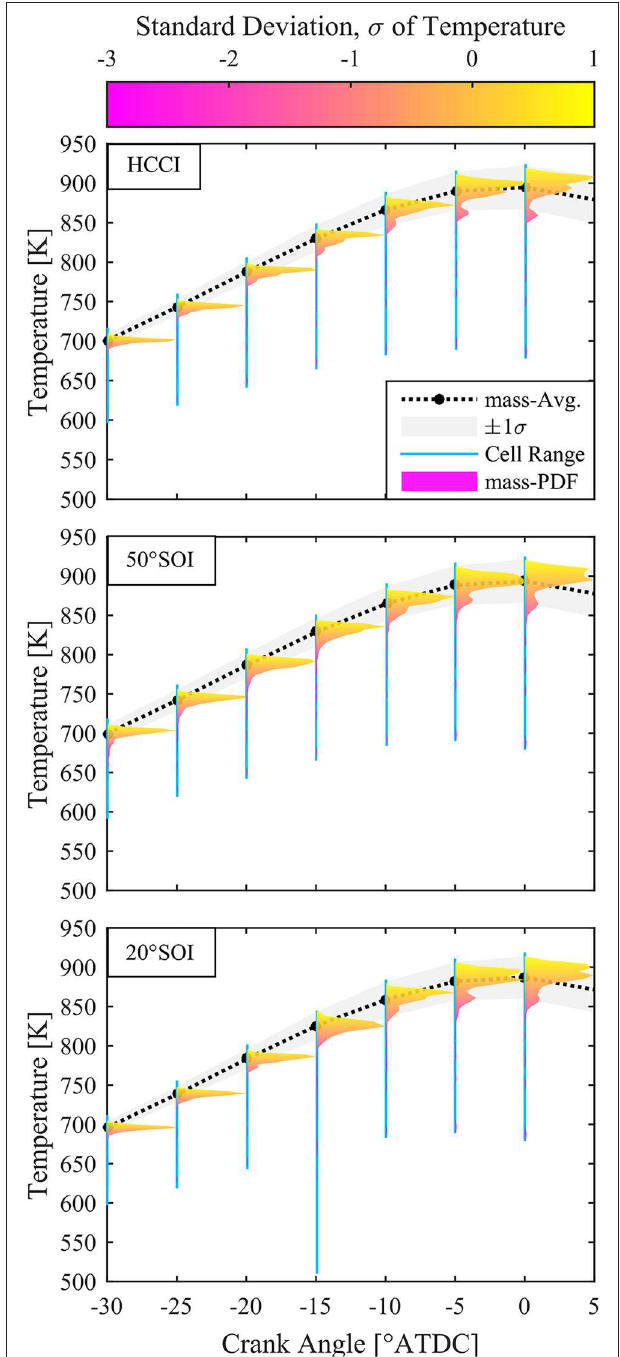
FIGURE 5 | Temperature evolution as a function of crank angle for representative HCCI (Top) and RCCI cases with SOI of − 50 ◦ (Middle) and SOI of − 20 ◦ (Bottom) , with the mass-weighted PDF of temperature colored by multiple of σ .